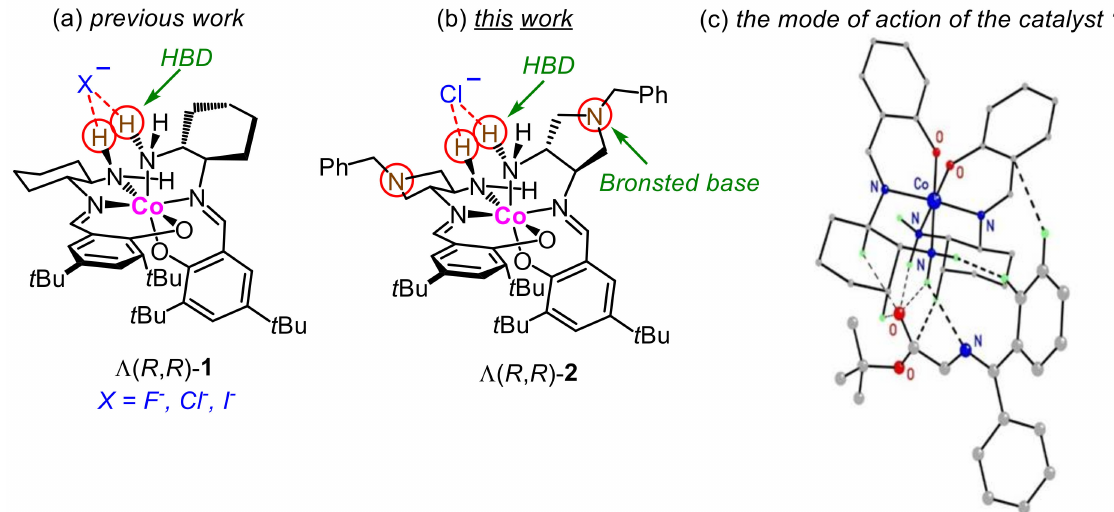
Figure 1. The structures of the chiral cobalt(III)-templated complexes: ( a ) Previous work— Λ ( R , R )- 1 ; ( b ) This work— Λ ( R , R )- 2 ; ( c ) The optimized structure of the ion pair formed between the Z-configured enolate of O’Donnell’s substrate and the cobalt(III) catalyst 1 (Reprinted with permission from Ref. [10]. Copyright © 2014 Wiley-VCH Verlag GmbH and Co.,